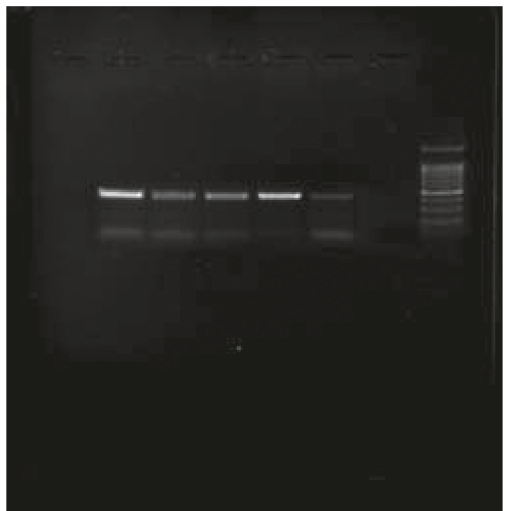
Figure 8: PCR product electrophoresis of 410bp algU gene (from left, lanes 1–4: positive samples, lane 4: positive control, lane 5: negative control, and lane 6: marker